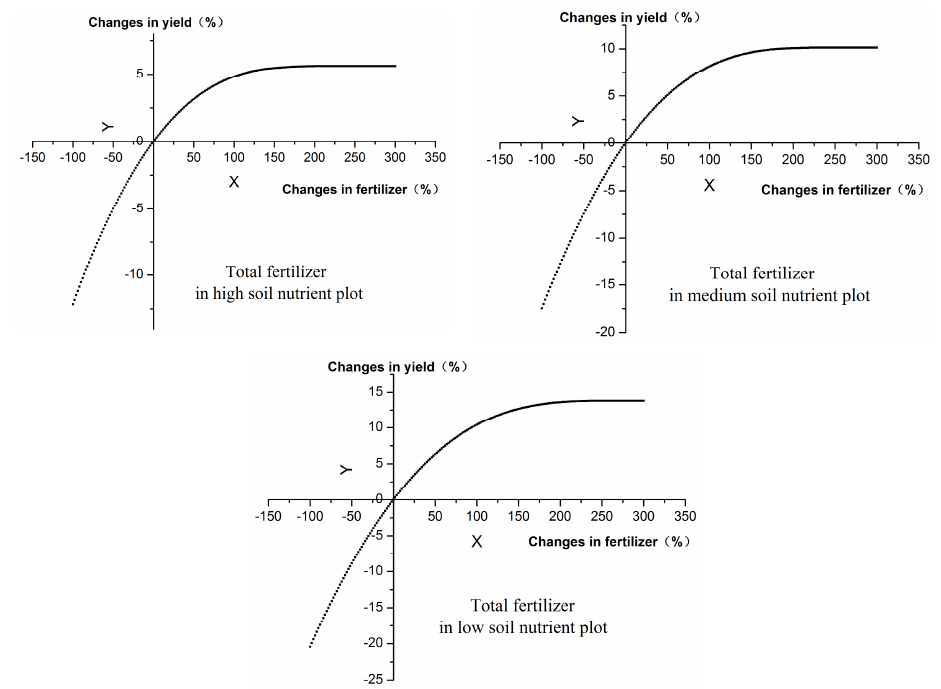
Figure 5. The results of crop growth simulations using different WOFOST-based fertilization levels.